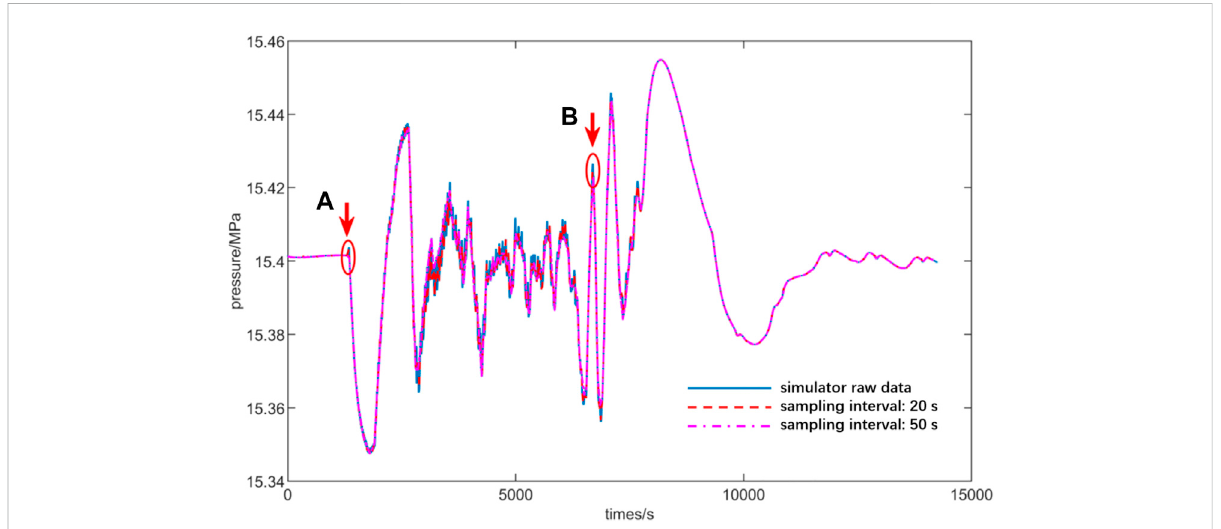
FIGURE 3 Sensitivity study of the sampling time intervals (the red arrows indicate the two largest local differences between different sampling intervals, which will be reviewed in Figure